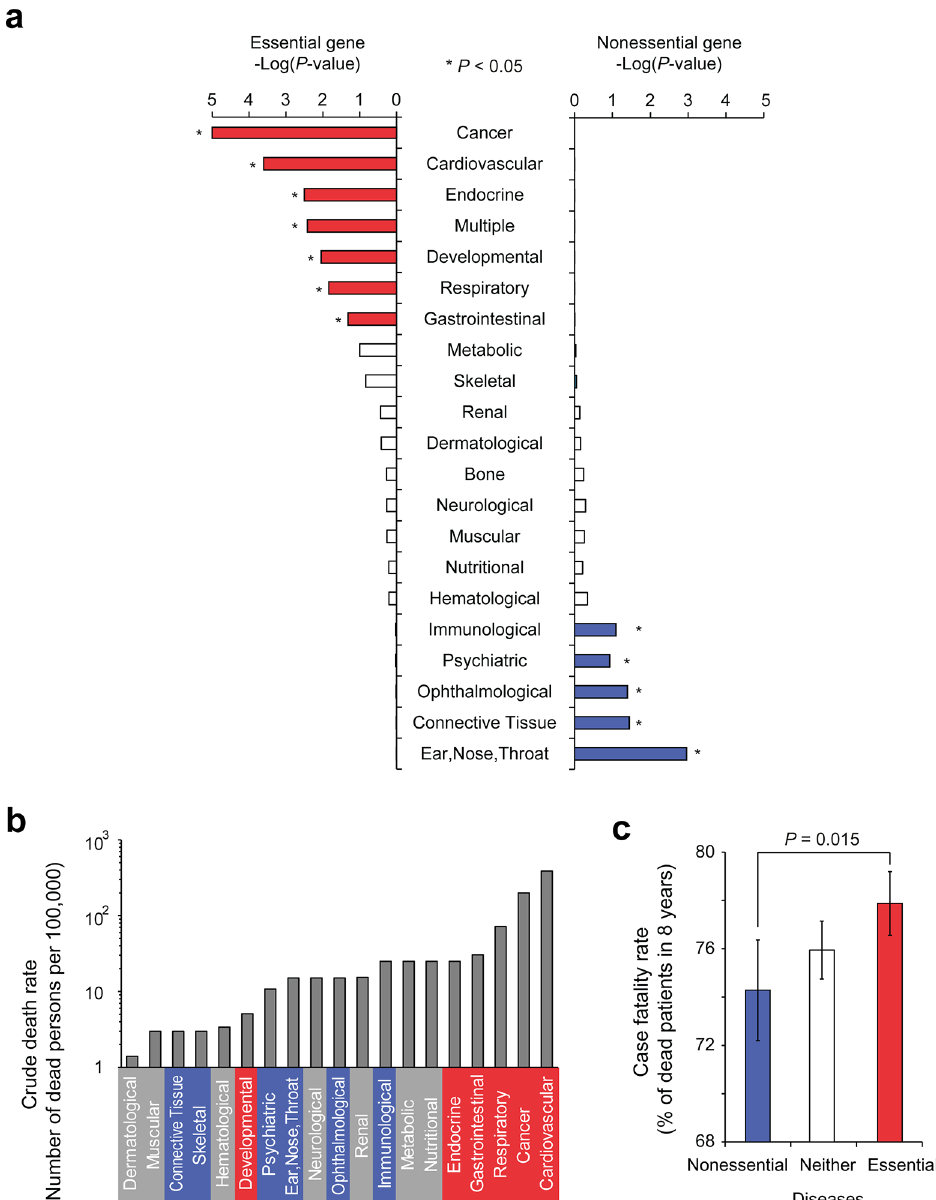
Fig 3. The mortality of human disease classes according to gene essentiality. (a) Human disease classes sorted by gene essentiality. The enrichment of essential and nonessential genes in 21 human disease classes is shown. * indicates P < 0.05 (Hypergeometric P -values). (b) The crude death rate of different disease classes. The crude death rate is calculated as the number of deaths reported each calendar year per 100,000 individuals. Disease classes that are enriched with essential and nonessential genes are colored in red and blue, respectively. (c) The case fatality rate of diseases differentially enriched with essential and nonessential genes. The case fatality rates of diseases enriched with neither essential nor nonessential genes are also shown as “ Neither ” .